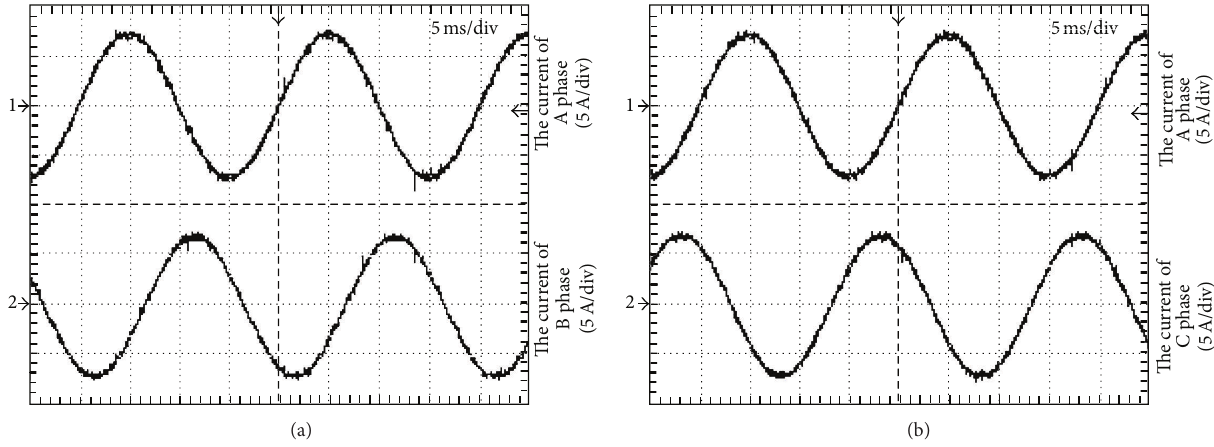
Figure 11: The three-phase load current with integrated filter inductor with five limbs: (a) the current of A phase and B phase, (b) the current of A phase and C phase. In CH1, the current comes from the current transformer and the proportion is 1V = 5 A; it means that the current per DIV is 5A; in CH2, the current per DIV is 5A; the time per DIV is 5